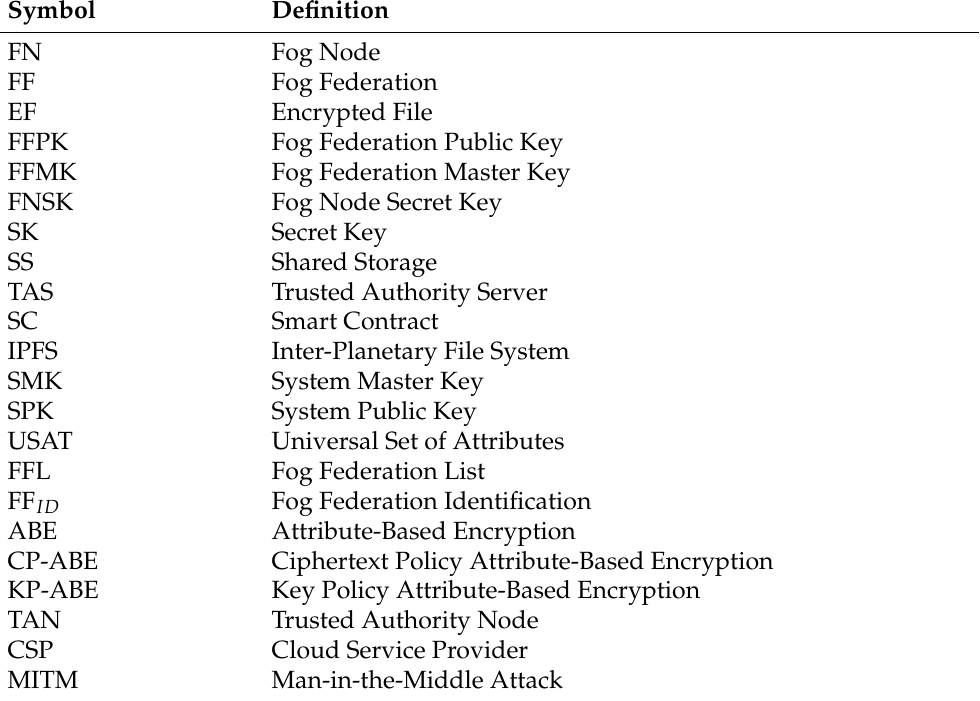
Table 2. Symbols and